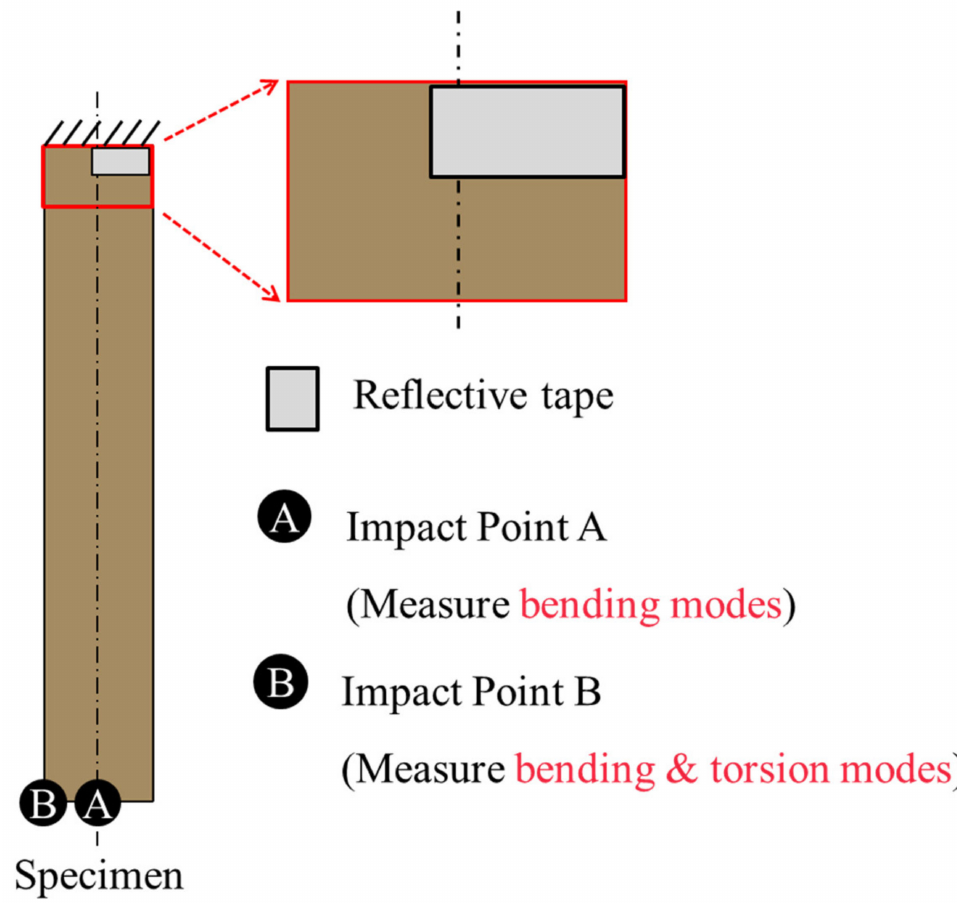
Figure 1. Schematic of impact points on cantilever